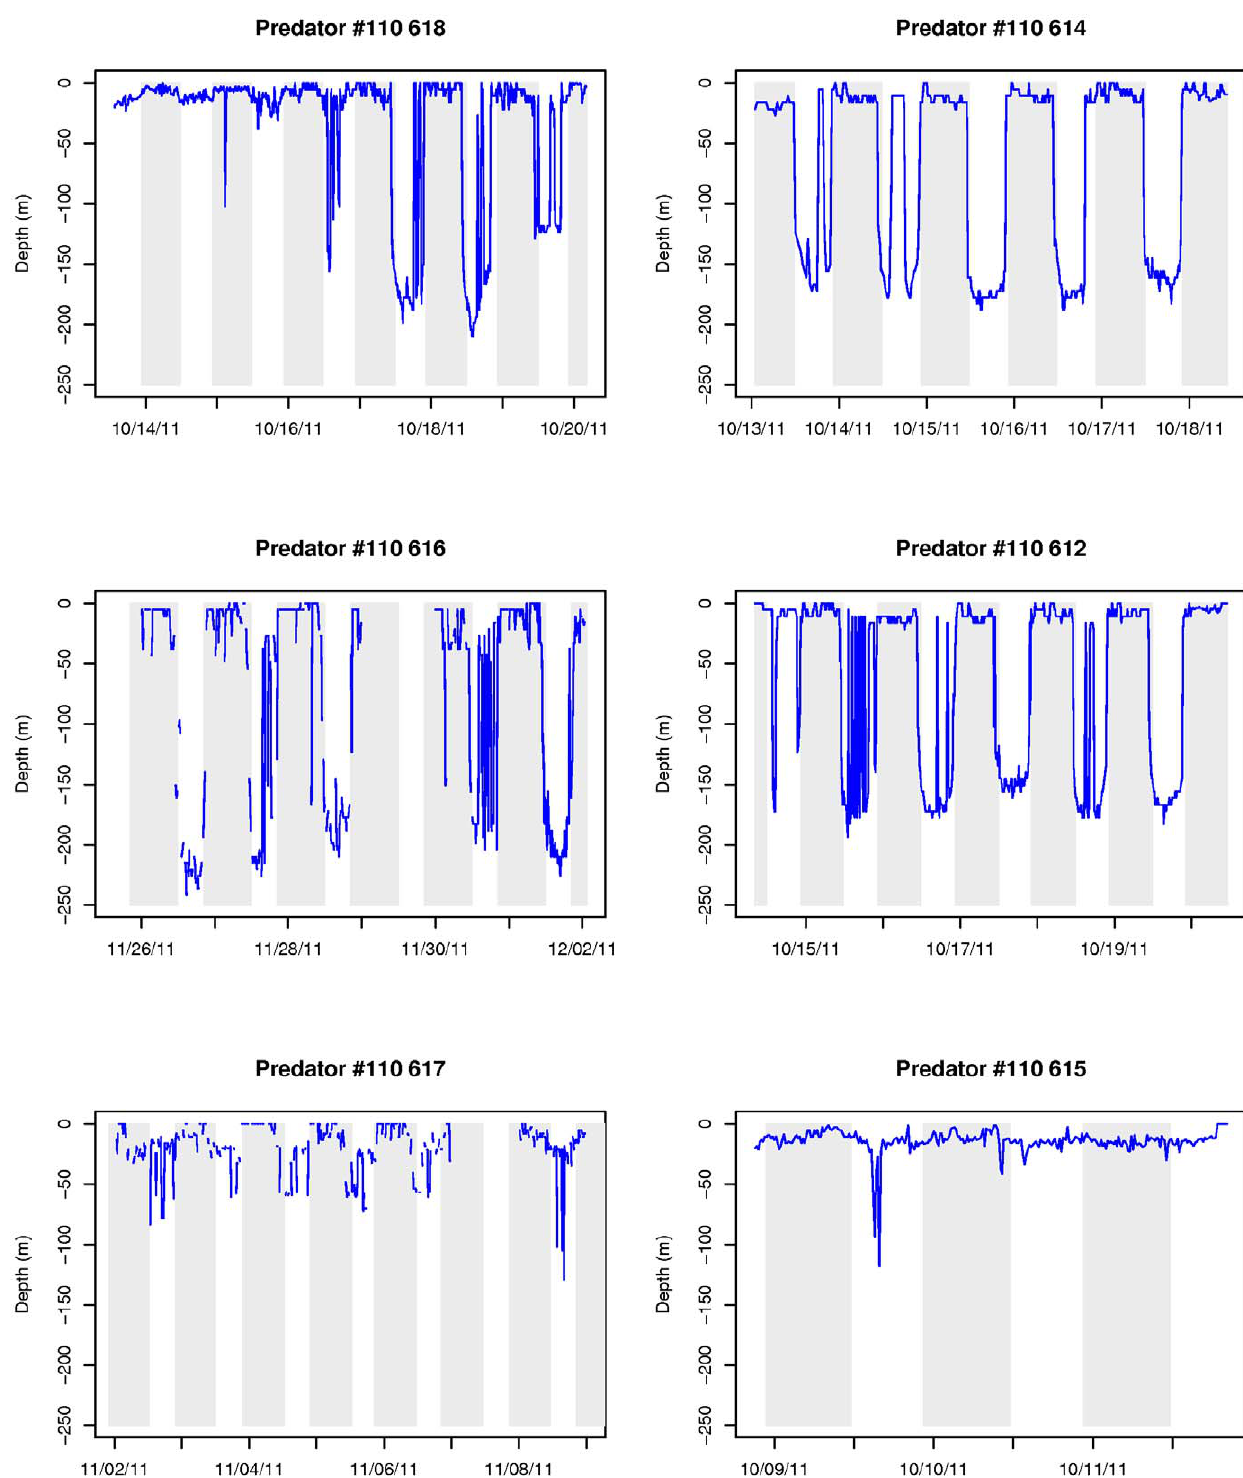
Figure 4. Vertical migratory behavior of the six eel predators. The gray parts represent night period.